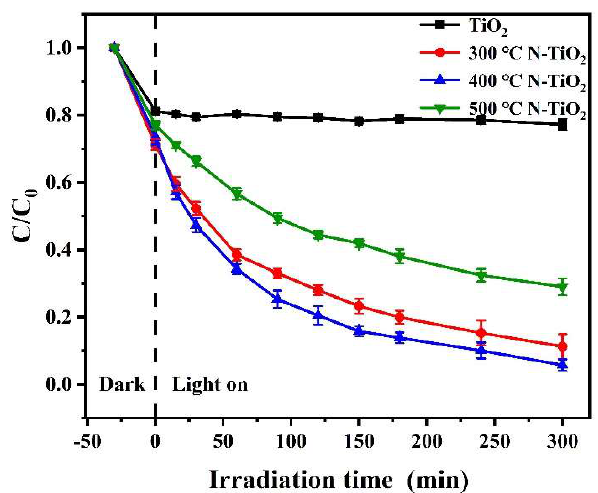
Figure 5. Photocatalytic degradation of MB by TiO 2 and N-TiO 2 calcinated under different temperatures.